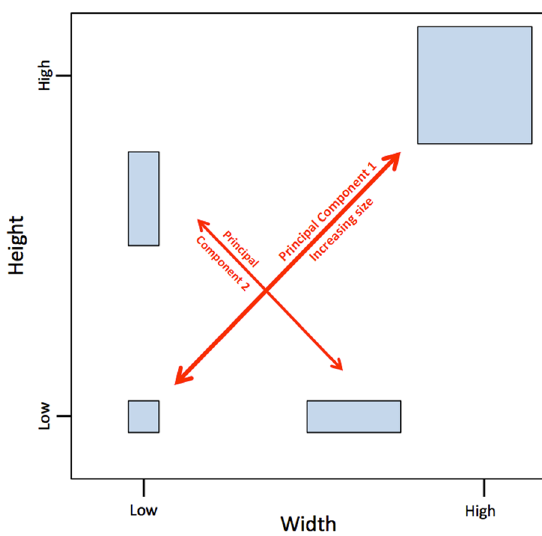
Fig. 5 A simpli fi ed demonstration of how size can drive covariance between two characters. In this two-dimensional example, relative size is indicated by the position of points along the trend line, which corresponds to the fi rst axis returned by principal components analysis. Variations in shape are indicated by position on the orthogonal second component. A positive correlation between traits may be driven by factors other than size, therefore this study uses 21 characters, rather than just